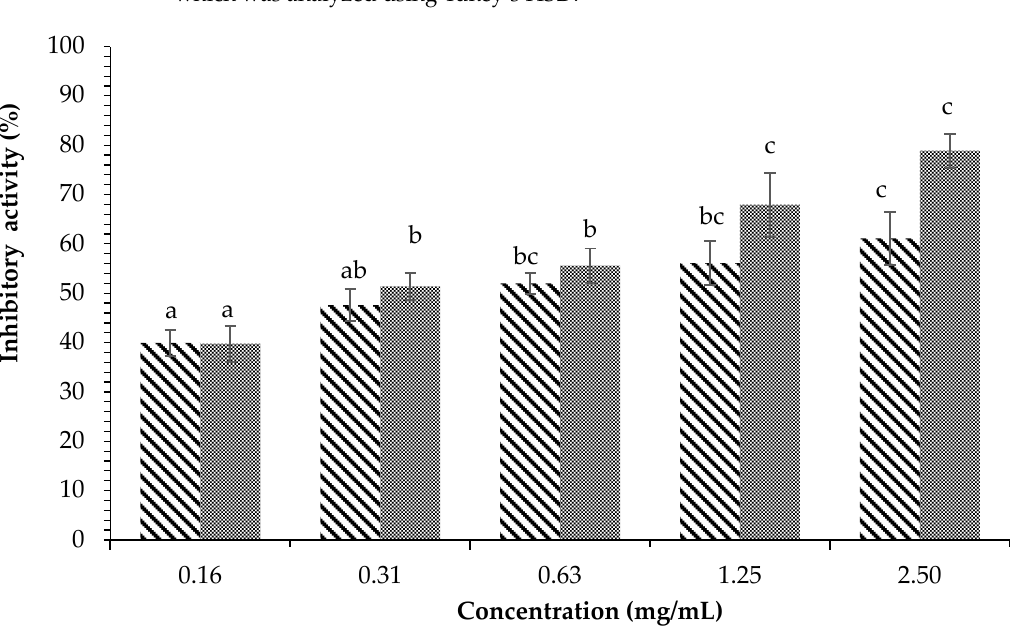
Figure 5. Effects of concentration of ethyl acetate fraction of H. tuna ( ) and Acarbose ( ) on α -glucosidase inhibition. Each value is expressed as mean ± SD in the triplicate experiment. Values (a–e) with different alphabet letters indicate significant differences among treatments at p < 0.05, which was analyzed using Tukey’s HSD.